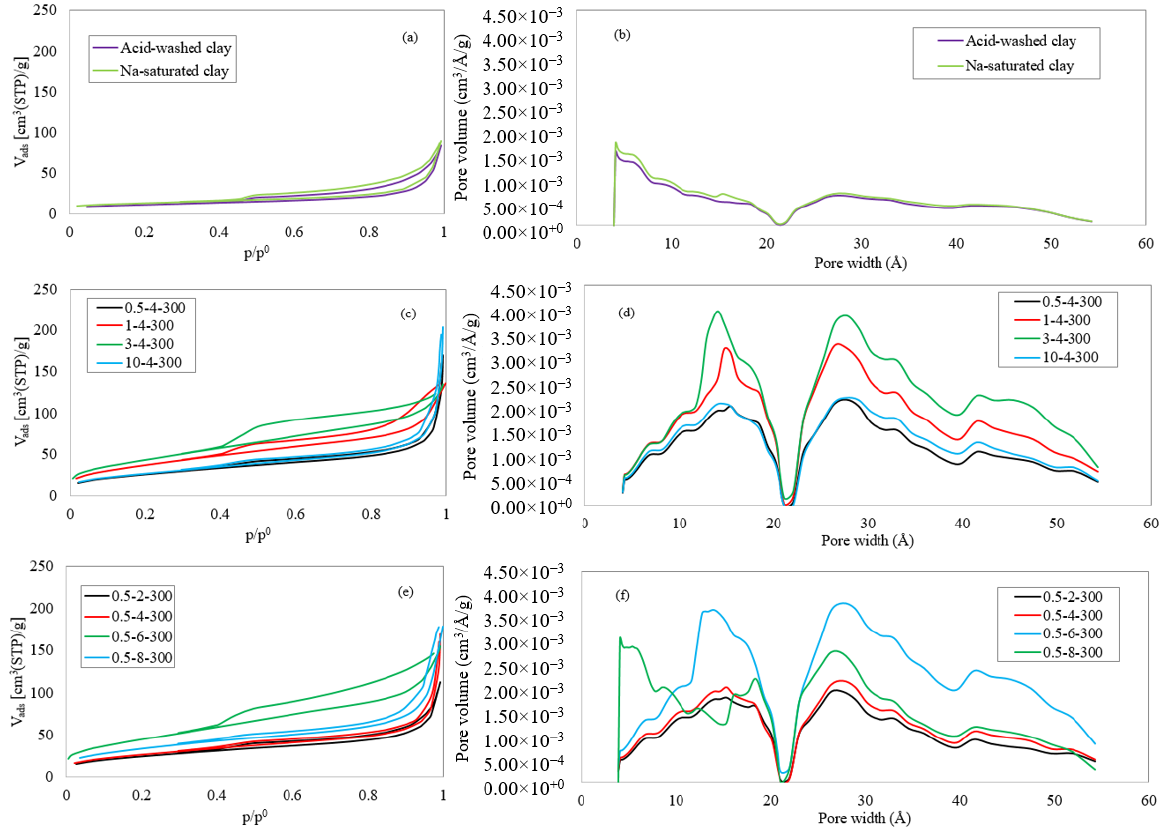
Figure 8. N 2 adsorption–desorption isotherms of ( a ) acid-washed and Na-saturated bentonites, and Ti-PILCs produced under different ( c ) clay suspension concentrations, and ( e ) H + /Ti ratios; DFT pore size distribution curves of ( b ) acid-washed and Na-saturated bentonites, and Ti-PILCs produced under different ( d ) clay suspension concentrations, and ( f ) H + /Ti ratios. Table 3. Porous properties of Ti-PILCs obtained at different operating conditions in comparison with the acid-washed and Na-saturated bentonites *.